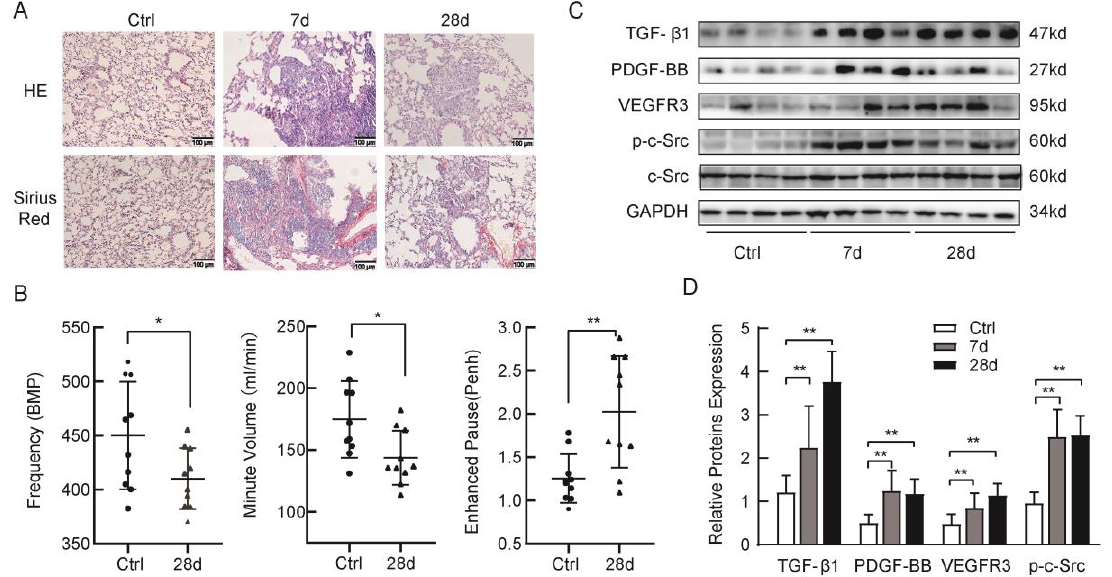
Figure 1. Silica-induced lung fibrosis and upregulation of p-c-Src tyrosine kinases, TGF- β 1 in mice. ( A ) HE showed the formation of irregular cellular nodule in the 7-d group and granuloma in the 28-d group in model mice. Sirius Red staining showed increased collagen deposition in model animals and confirmed the success of a mouse silicosis model. ( B ) Lung function evaluated in mice. Frequency (F) and minute volume (MVb) were decreased and enhanced pause (Penh) was elevated significantly in the 28-d model group compared with the control group. Note: Black dots represent the Ctrl group, black triangles represent the 28-d group. ( C ) The high-level expression of TGF- β 1, PDGF-BB, p-c-Src, and VEGFR3 was performed by Western blotting assay in the lung tissues of a murine model, compared with the control group. ( D ) p-c-Src, TGF- β 1, PDGF-BB, and VEGFR3 in the lungs of mice from the various groups. One-way analysis of variance and independent-samples t -test. * p < 0.05 and ** p < 0.01 versus control. The results are shown as mean ± SD, n =